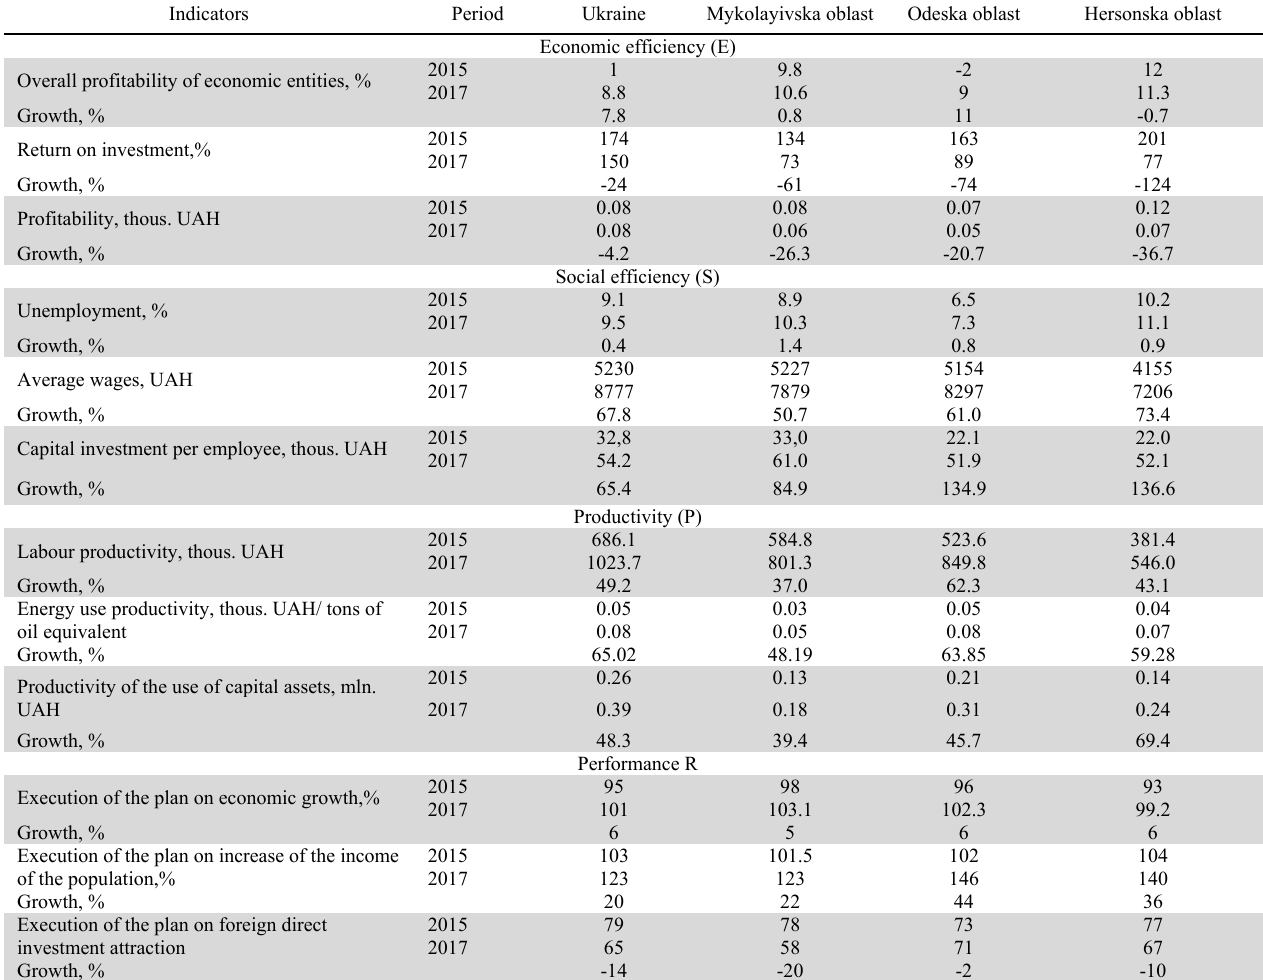
Indices of economic system management efficiency across oblasts of the Black Sea region of Ukraine Indicators